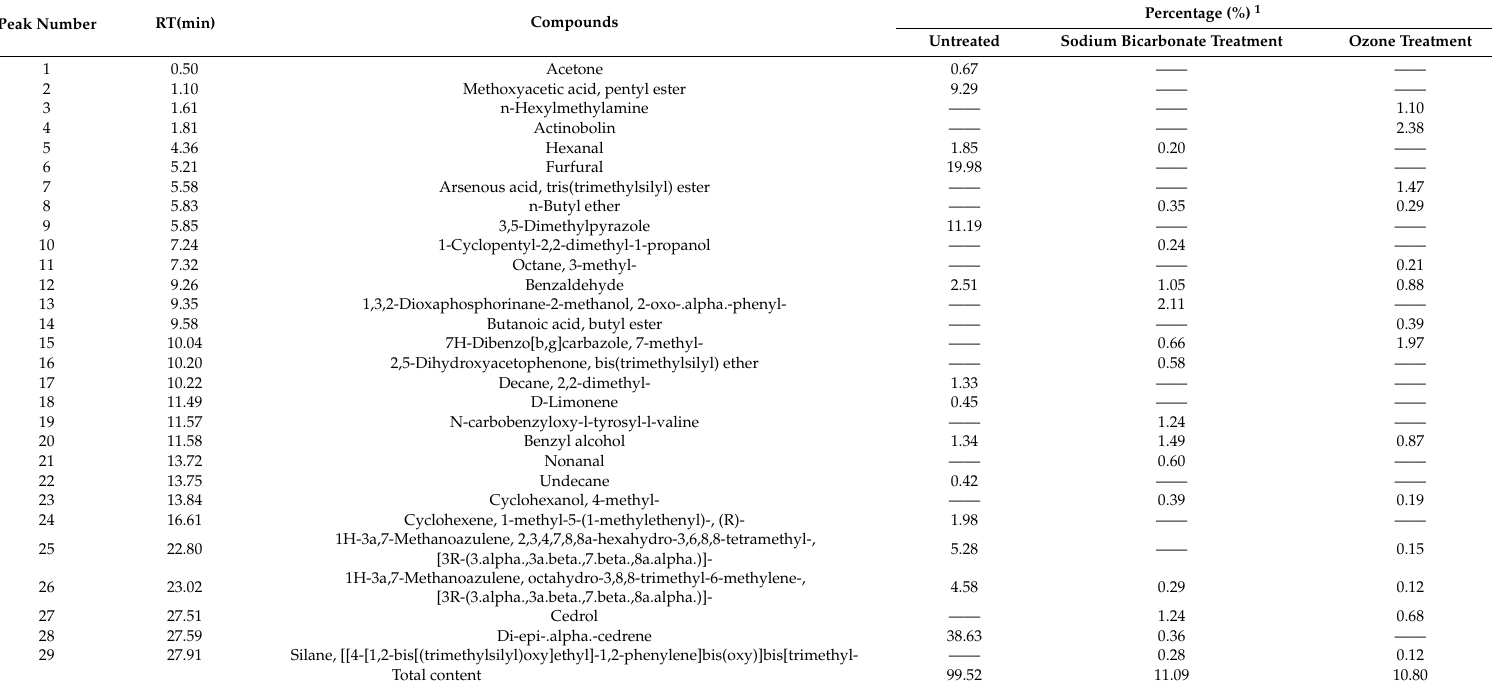
Table 3. Comparison of volatile organic compound (VOC) contents of untreated and treated